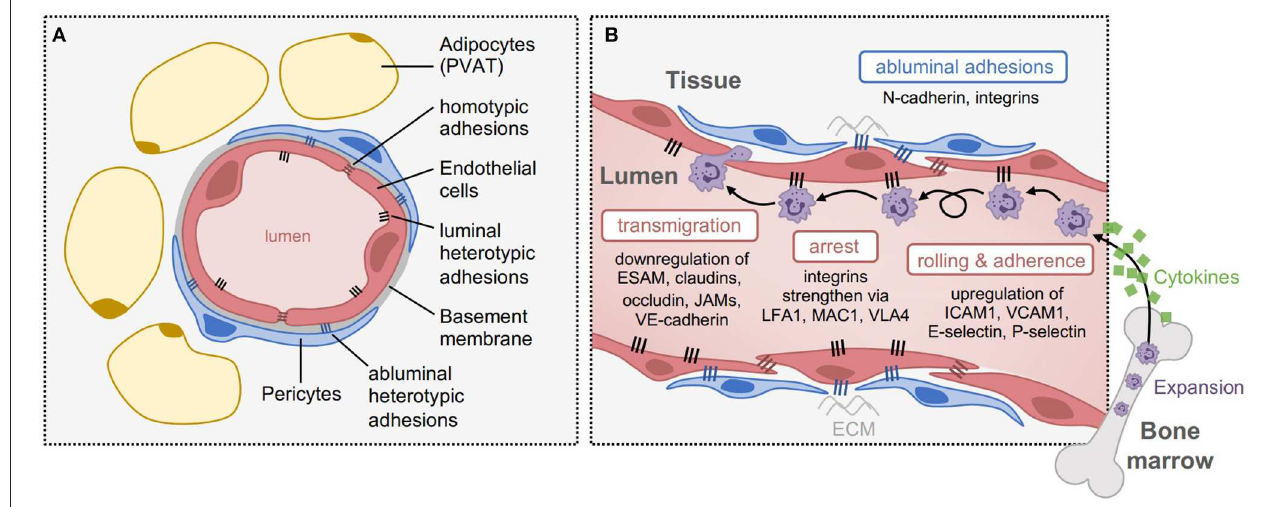
FIGURE 1 | Structure and function of the endothelium during vascular inflammation. (A) Structure of blood capillaries, with surrounding perivascular adipose tissue (PVAT). The lumen is formed by 1-2 endothelial cells that are sealed by homotypic junctional adhesions, including tight junctions and adherens junctions. The endothelial cells are bound to a specialized basement membrane, and enveloped with pericytes once mature. On their luminal side, endothelial cells express heterotypic adhesions that assist with cell attachment within the periphery, and on their abluminal side, they express distinct heterotypic adhesions (e.g., N-cadherin and integrins) that facilitate pericyte coverage and attachment to the extracellular matrix (ECM). (B) Adhesions involved in different steps of leukocyte transmigration. In response to inflammation, cytokines are released to cause expansion and recruitment of leukocytes from the periphery, such as neutrophils from the bone marrow. Upon arrival at the inflamed tissue, leukocytes roll and adhere to the endothelium through luminal adhesion proteins including upregulation of E-selectin, P-selectin, ICAM1, and VCAM1. To induce their arrest, integrins strengthen these interactions through interactions with LFA1, MAC1, and VLA4, which are expressed by leukocytes. Once arrested, transmigration can occur through endothelial junctions, by downregulating homotypic adhesions such as ESAM, claudins, occludin, JAMs, and